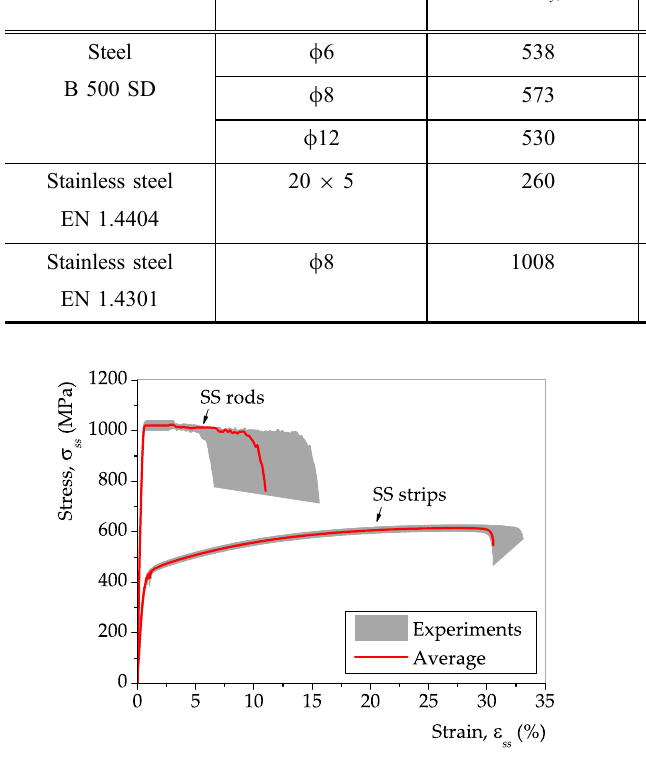
Fig. 1 Stress-strain behaviours of the stainless steel strips and